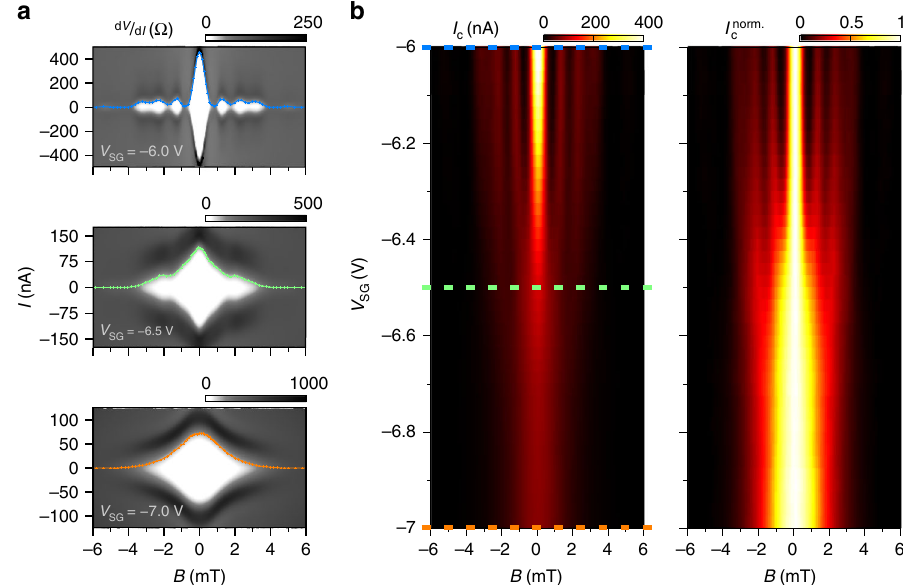
Fig. 4 Magnetic interferometry study of the transition from 2D to 1D con fi nement of the supercurrent. a Grey-scale map of the differential resistance d V /d I versus magnetic fi eld B and current I . The coloured dotted lines correspond to the extracted I c . These measurements are taken at three different split-gate voltage values ( V SG = − 6, − 6.5 and − 7 V) at constant charge carrier density ( V BG = 8 V). Drastic change in the interference pattern is observed highlighting a clear transition from 2D to 1D con fi ned supercurrent. b Critical current amplitude I c (left panel) and normalised critical current amplitude I norm : (right panel) mapped as a function of magnetic fi eld B and split-gate voltage V SG . The transition from a beating pattern (Fraunhofer-like) to a c monotonically decaying pattern is visible con fi rming the continuous change in the supercurrent con fi nement from 2D to 1D. The coloured dashed lines correspond to the split-gate values where the d V /d I ( V SG , B ) maps were measured in panels